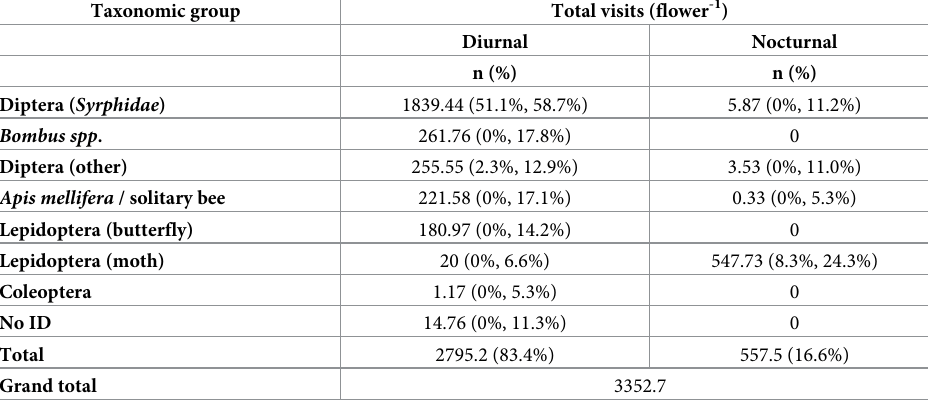
Visitation counts are separated by time period (diurnal and nocturnal), with the percentage of the total nocturnal and diurnal visitation count for each species group represented by lower and upper 95% confidence intervals, calculated using the Wilson score interval.